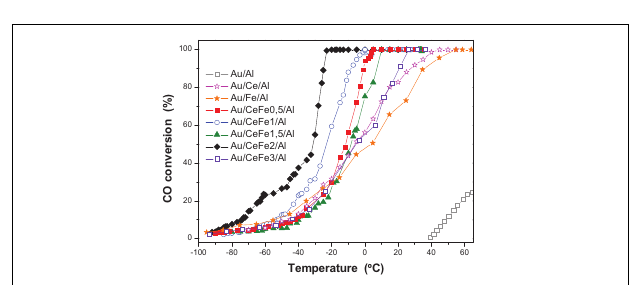
FIGURE 8 | Sub-ambient CO oxidation light-off curves of the gold catalysts.